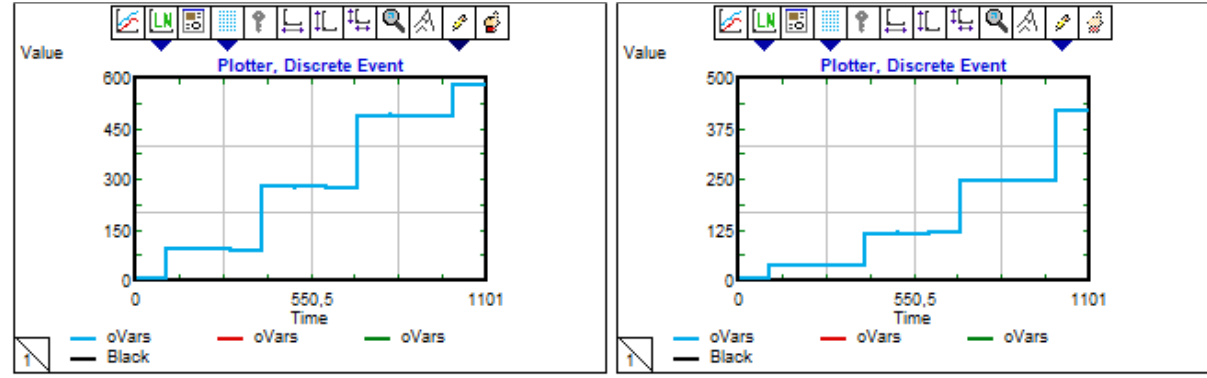
Figure 5: Graph of simulation after changes in time units of